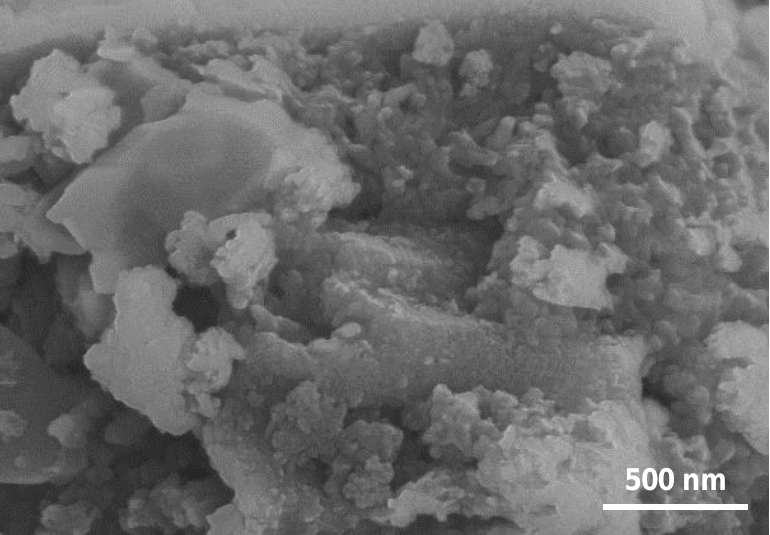
Figure 1. SEM images of 10% BP/KPHI.